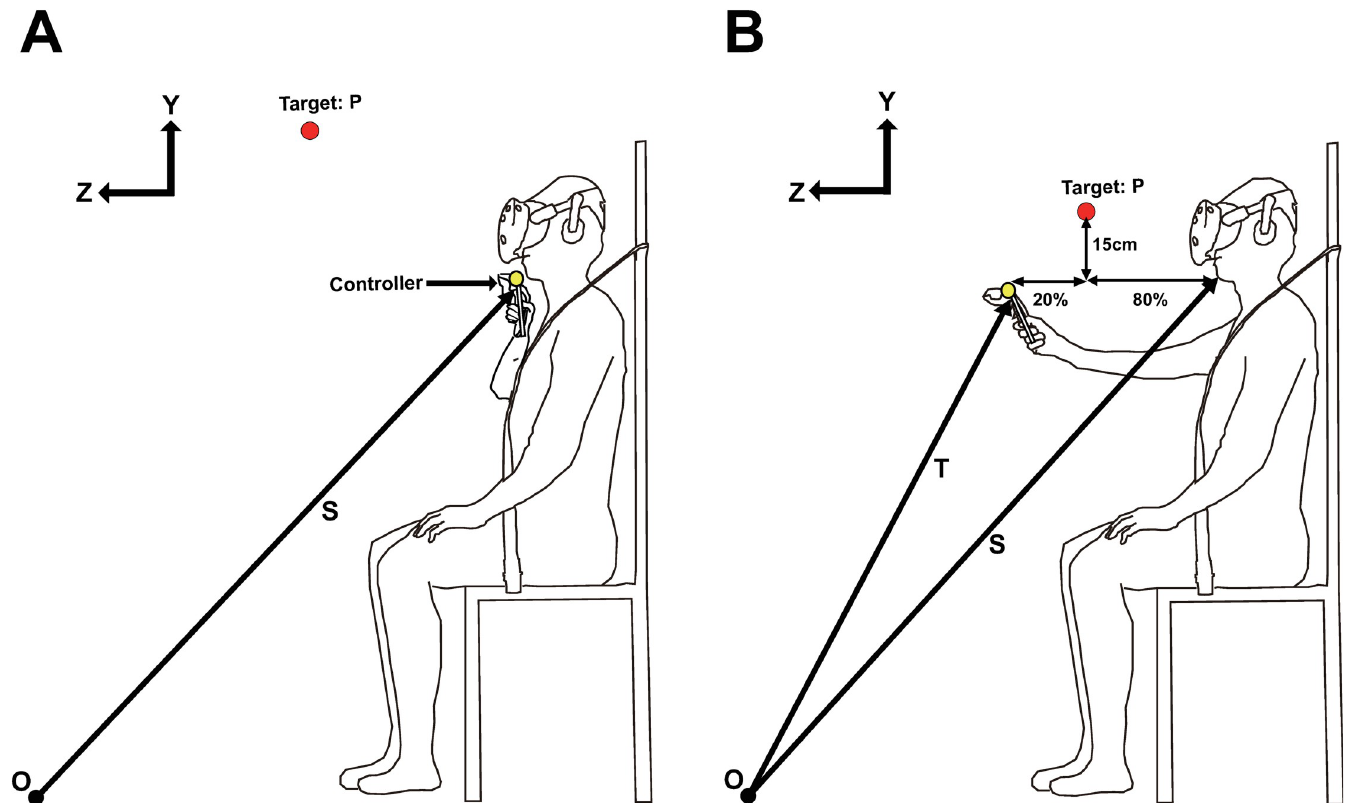
Fig 2. Calibration procedure. (A) Initialization of target x-axis position (B) Initialization of target y-axis, z-axis position. Process (A) is performed first, and then process (B) is performed to set the initial position of the x, y, and z axes of the target.